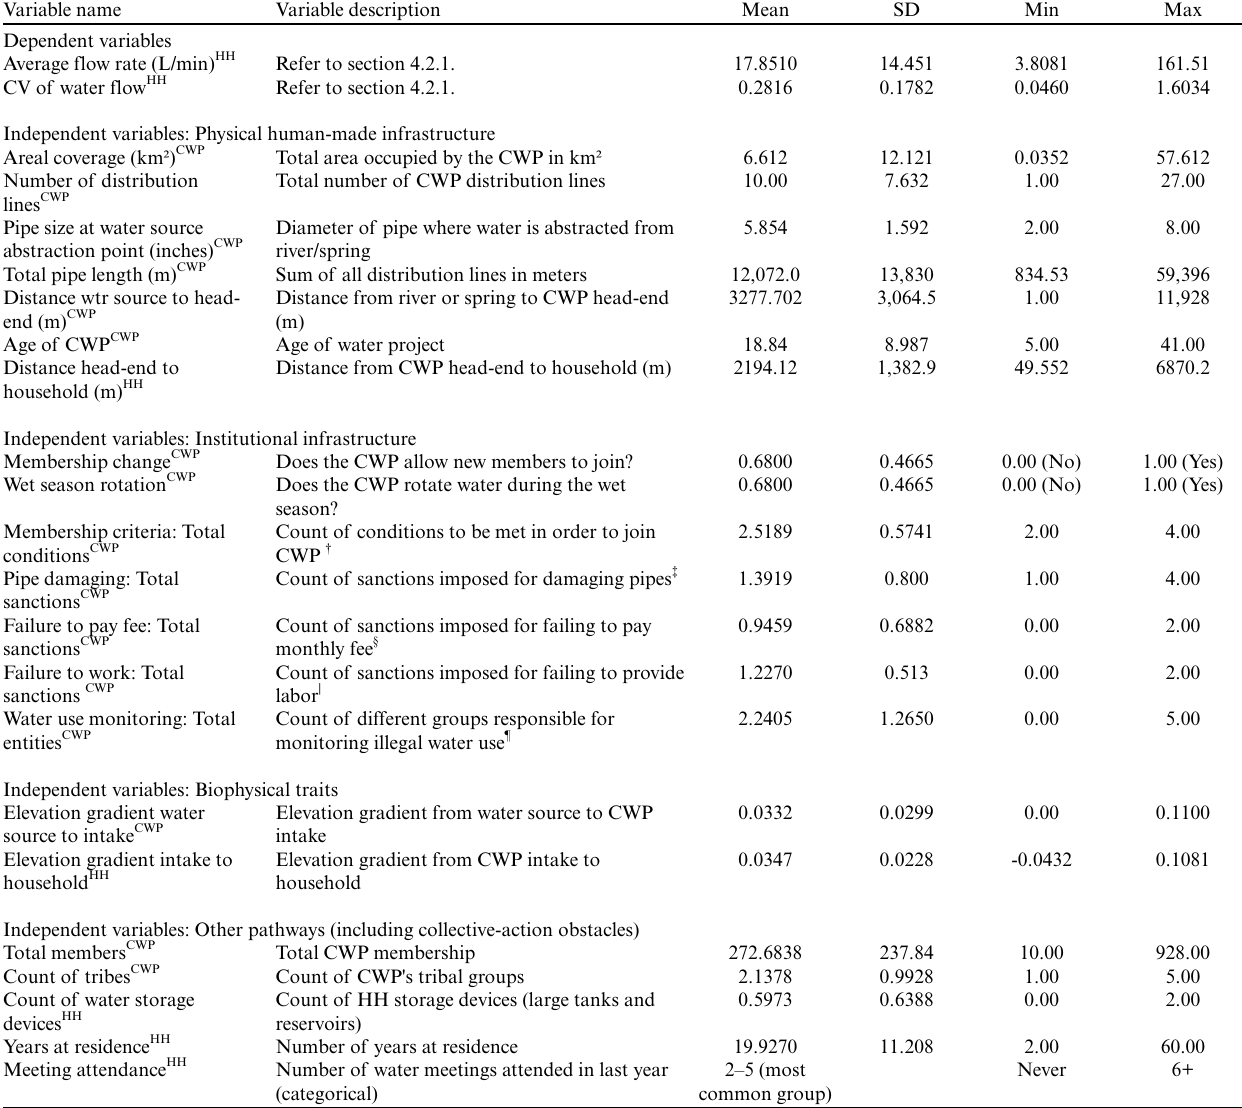
Table 4. Summary